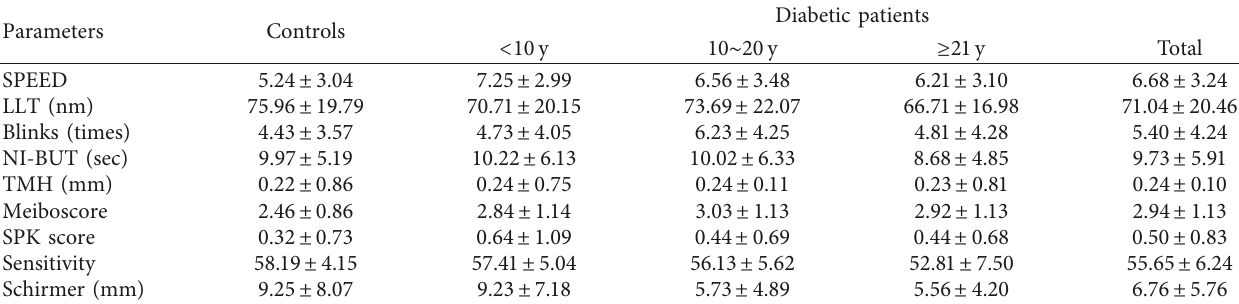
Table 3: Ocular surface clinical parameters in diabetic patients and normal controls.